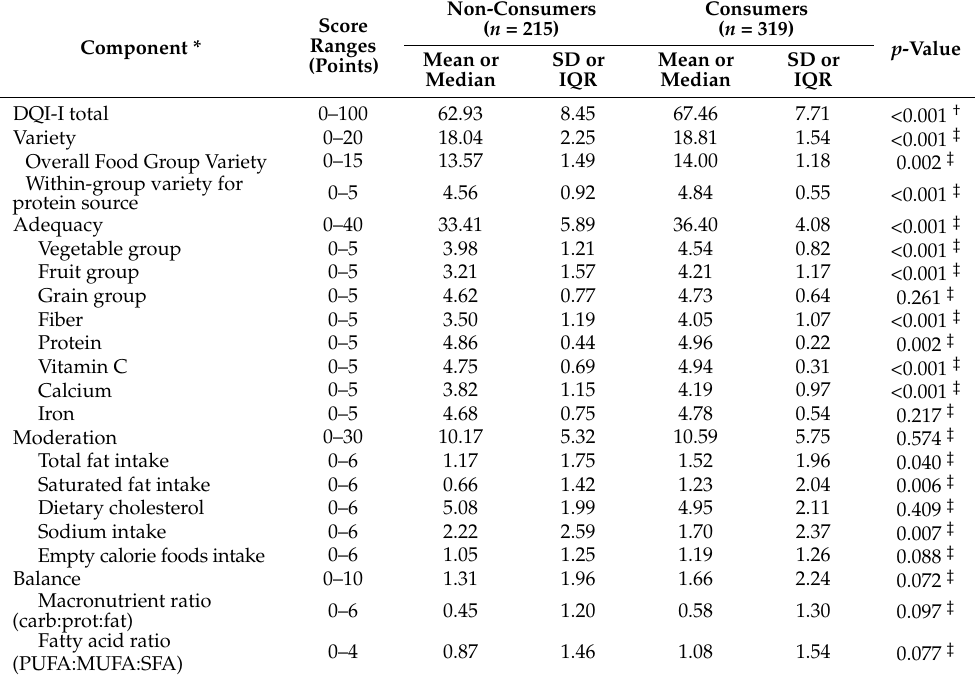
Table 3. Comparison of Diet Quality Index- International (DQI-I) and its component scores, and anthropometric measures between avocado consumers and